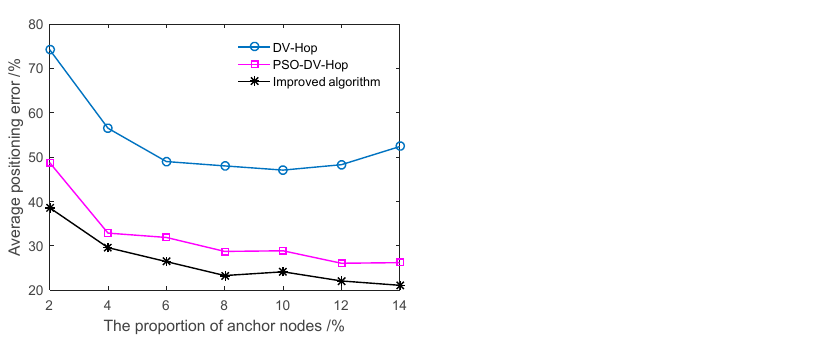
Figure 7. Relationship between the proportion of anchor nodes and the average positioning error.